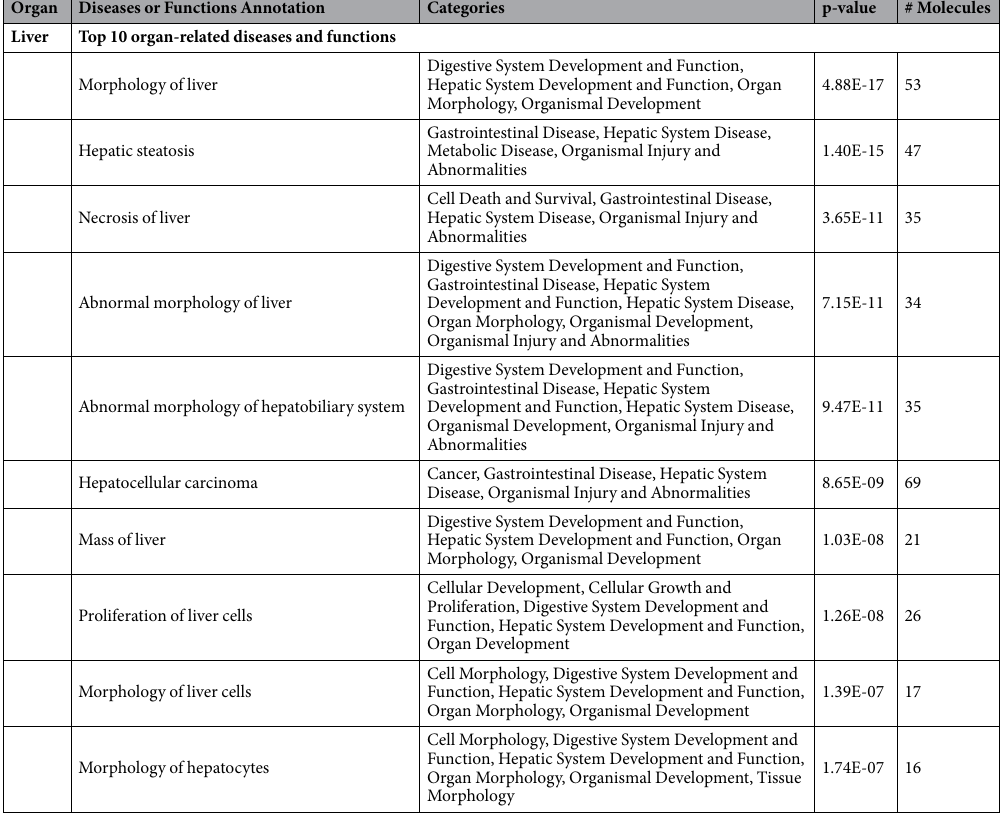
Table 1 . Individual diseases or function annotation pertaining to the specific organs and